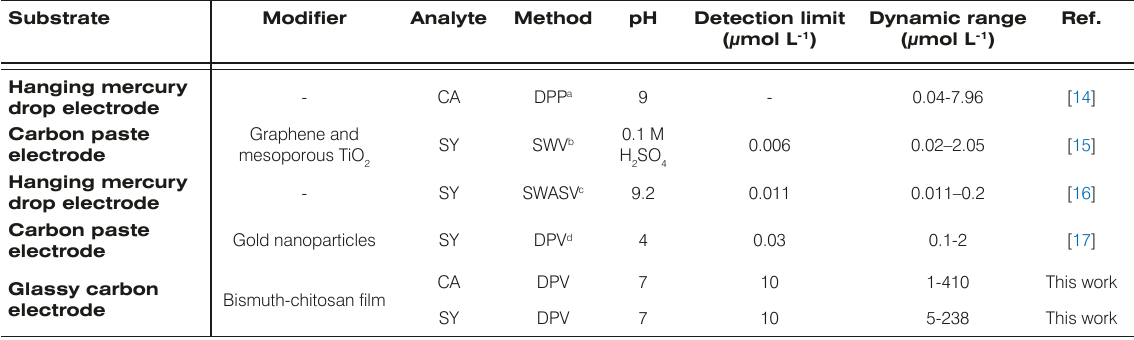
Table 1. Comparison of the efficiency of some voltammetry methods used in the electroanalytical determination of SY and CA.